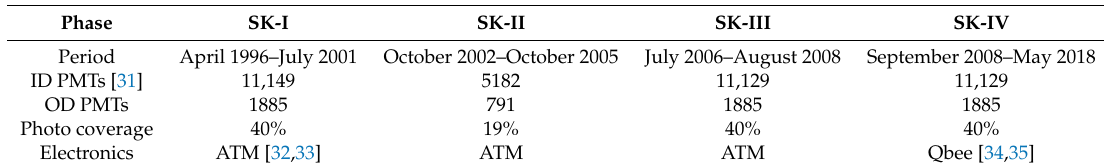
Table 2. Experimental phases of the Super-Kamiokande detector. ID, inner detector; OD, outer detector; PMT,